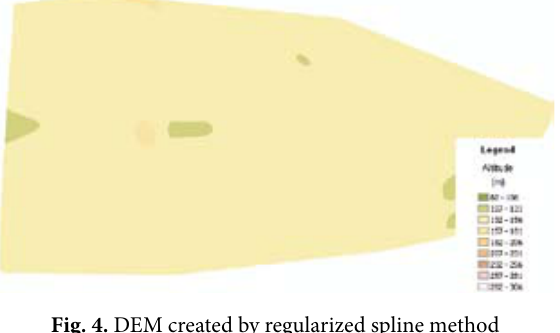
Fig. 6. DEM created by Kriging method